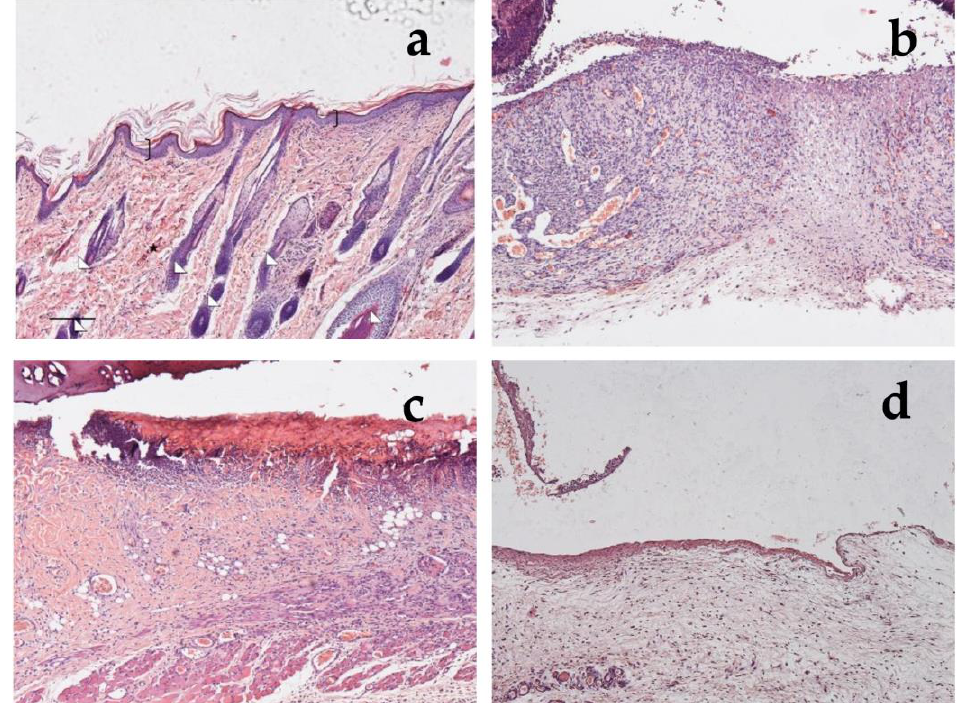
Figure 13. Section of healthy skin ( a ) and wounds after 7 days of treatment with saline solution ( b ), α -tocopherol ( c ), or CSO–CO 100 ( d ), stained with hematoxylin and eosin (bracket: pluristratified α -tocopherol ( c ), or CSO – CO 100 ( d ), stained with hematoxylin and eosin (bracket: pluristratified and cornified epithelium; triangles: large acidophilic bundles; star: skin and cornified epithelium; triangles: large acidophilic bundles; star: skin appendages).